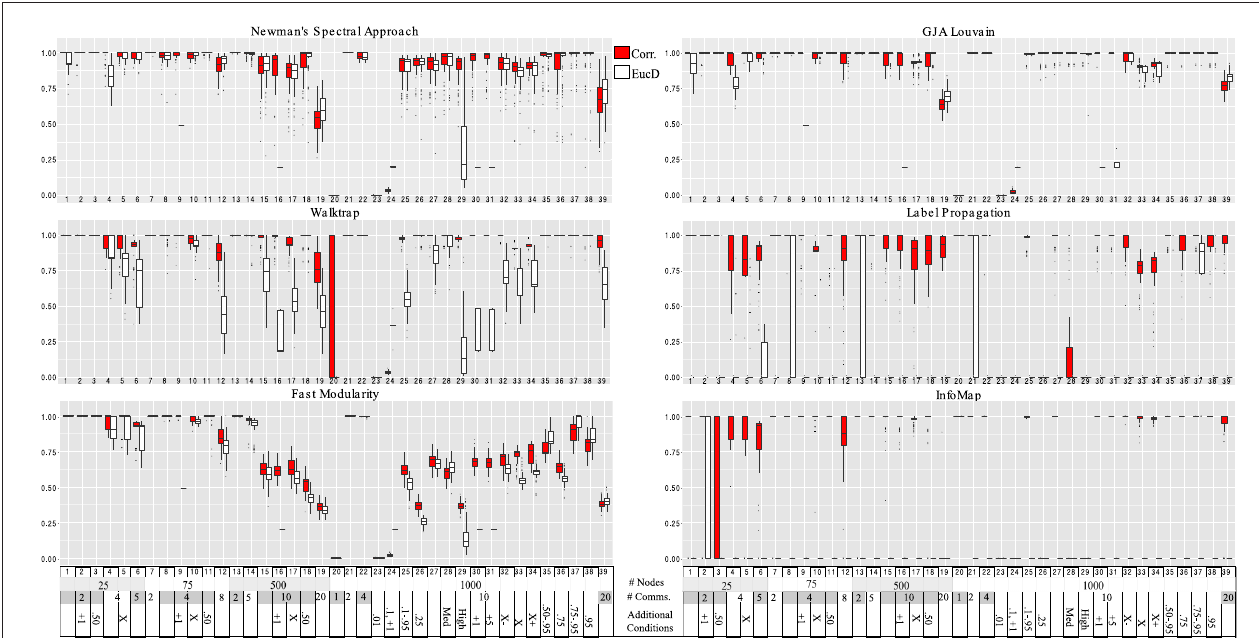
FIGURE 4 | Hubert-Arabie adjusted Rand Index ARI HA for correlation and reflected euclidean distance matrices. Simulation numbers correspond to those described in Table 3 . In the legend depicting the simulation parameters appended at the bottom of the graph, “Comms.” indicates communities; in the “Additional” row, numbers indicate the connectivity range (when not stated, it is 0.25–0.95); “X” indicates unequal group sizes, with “X − ” indicating more small groups than large and “X + ” indicating more large groups than small; “Med” and “High” indicate medium and high degrees of community overlap (i.e., correlation among communities), respectively. Infomap conducted on correlation matrices performed best for graphs with 25 nodes. Walktrap on correlation matrices outperformed the other methods for graph sizes ≥ 75 across the varied conditions. Walktrap and Infomap conducted on correlation matrices were the only approaches to not return false communities when there is only 1 community (Simulation